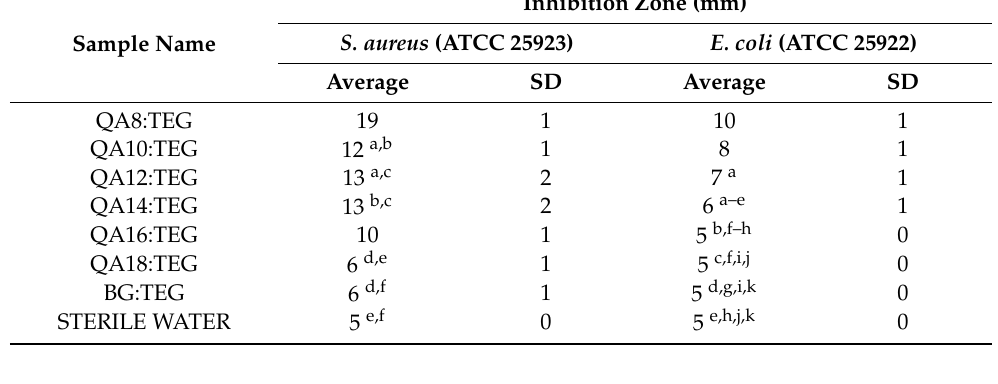
Table 4. S. aureus (ATCC 25923) and E. coli (ATCC 25922) growth inhibition zones. The value of 5 mm